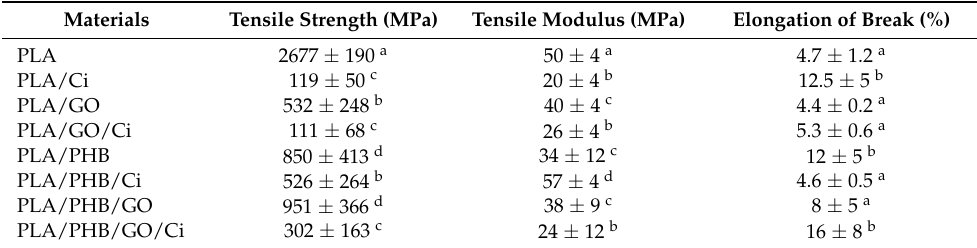
Table 1. Mechanical properties for the different materials